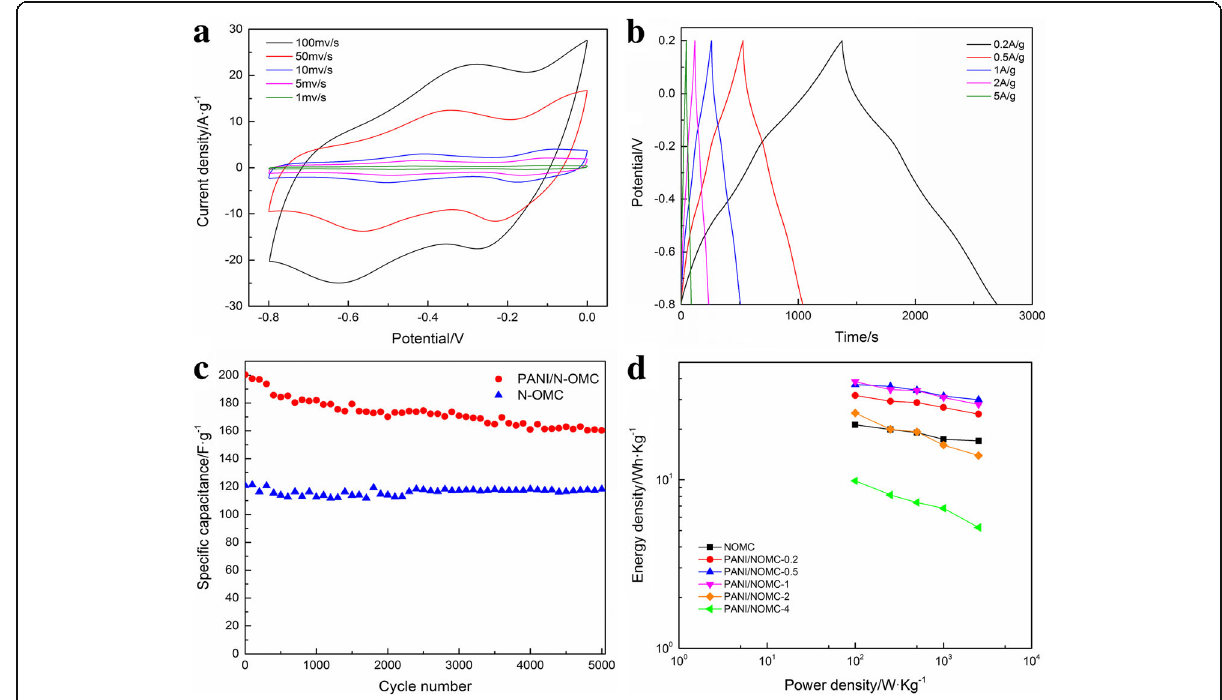
Fig. 5 CV curves of PANI/NOMC-0.5 ( a ). Galvanostatic charge/discharge curves of PANI/NOMC-0.2 ( b ). The cycling performance of